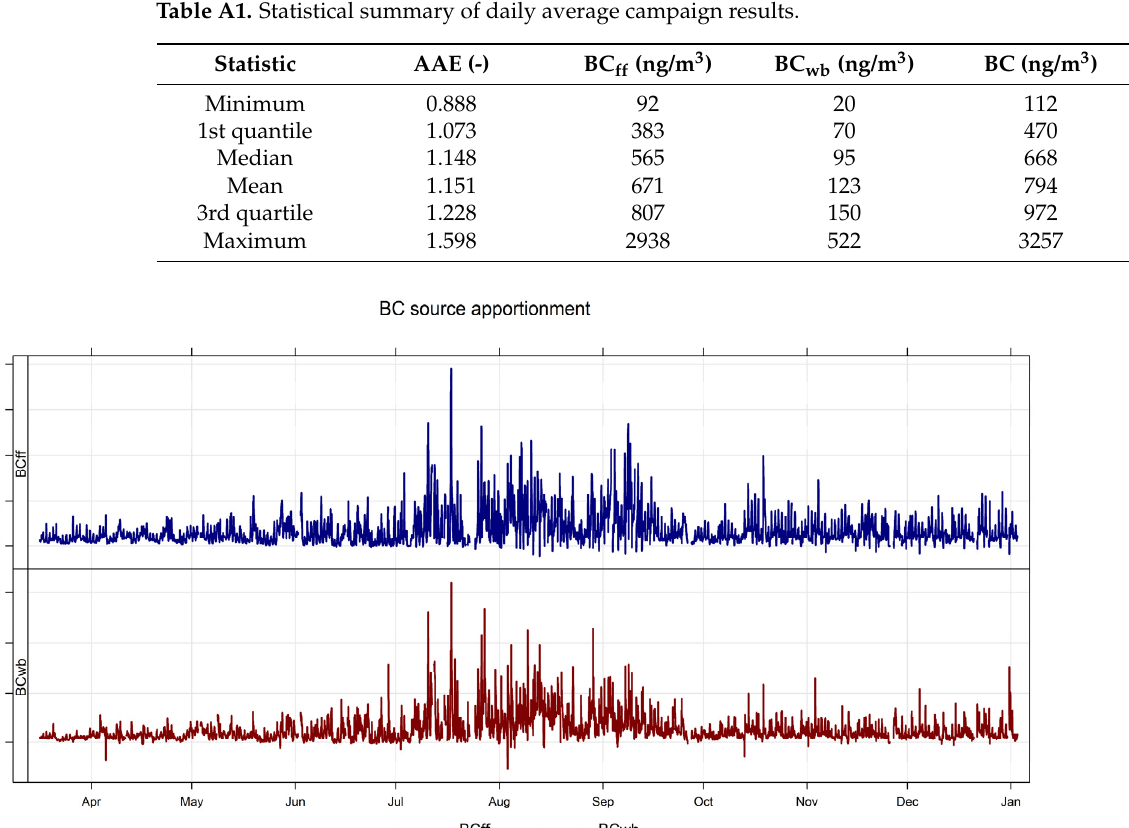
Figure A3. Time variability of BC wb concentrations, 2020 campaign. Appendix B. Bivariate Plots for BC ff and BC wb Using Temperature and Pressure In- stead of Wind Speed